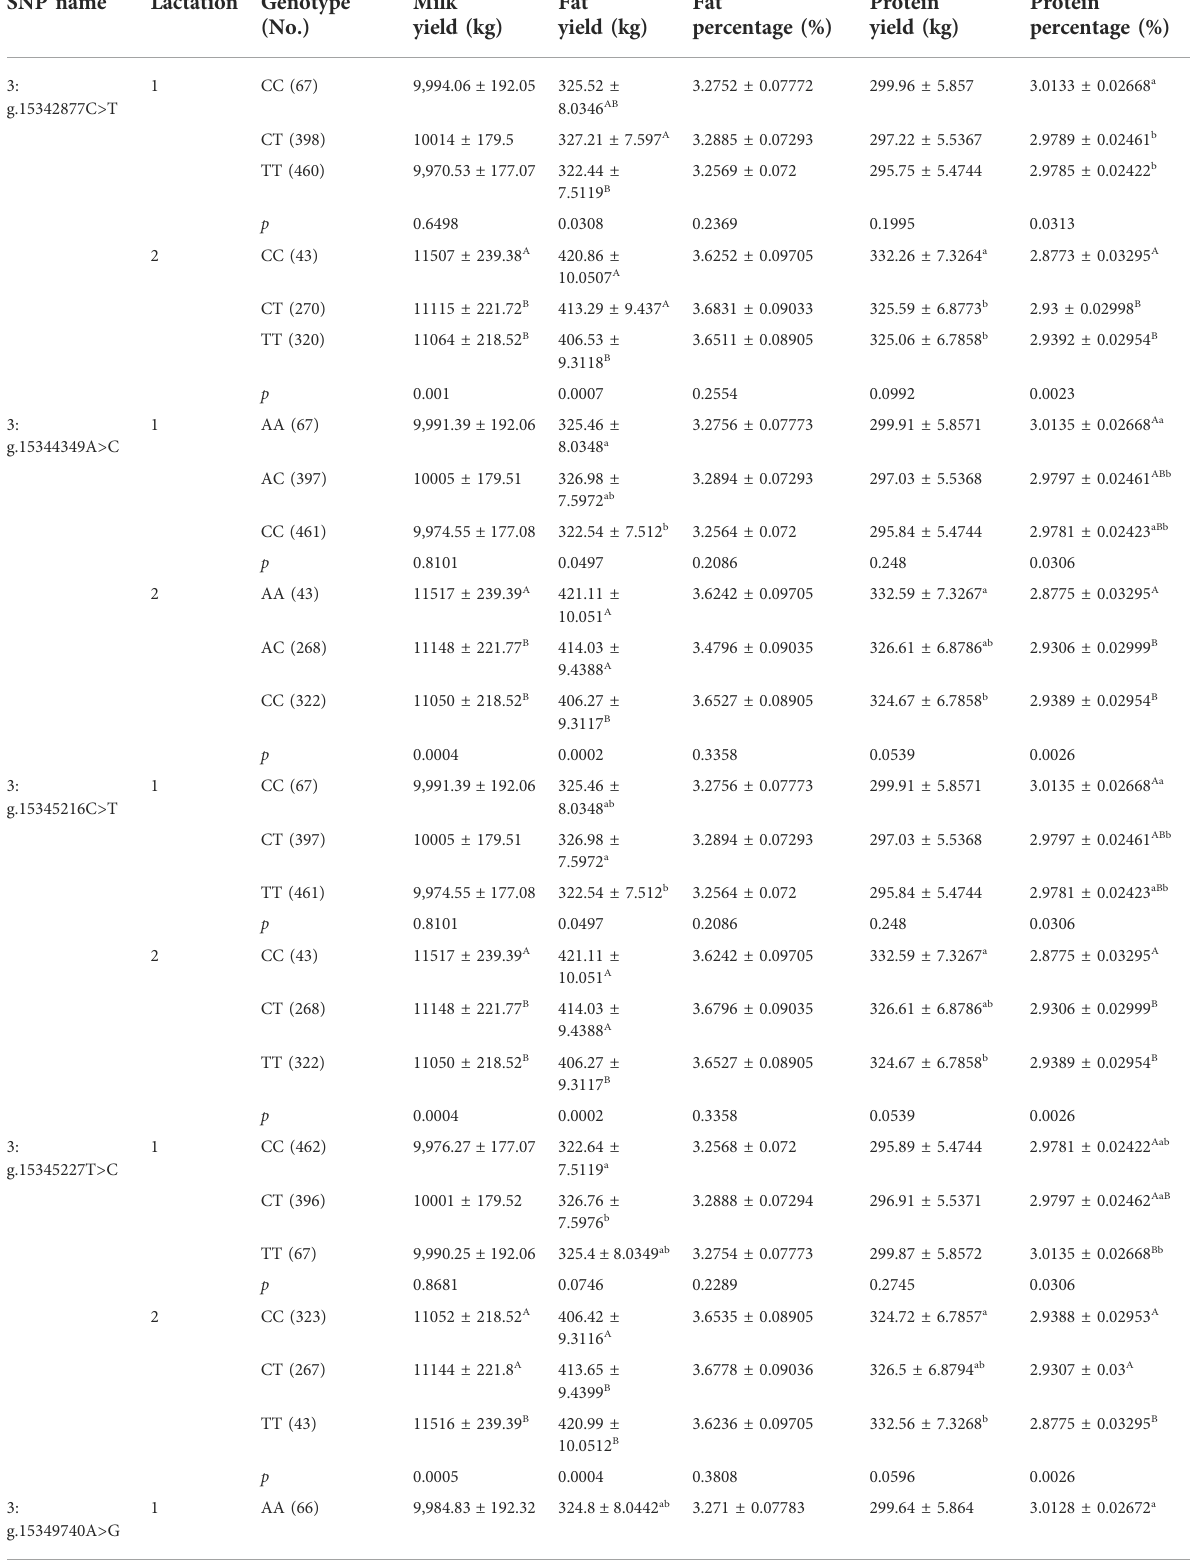
TABLE 2 Associations of 21 SNPs in PKLR with milk production traits in two lactations of Chinese Holstein cows (LSM ±SE). SNP